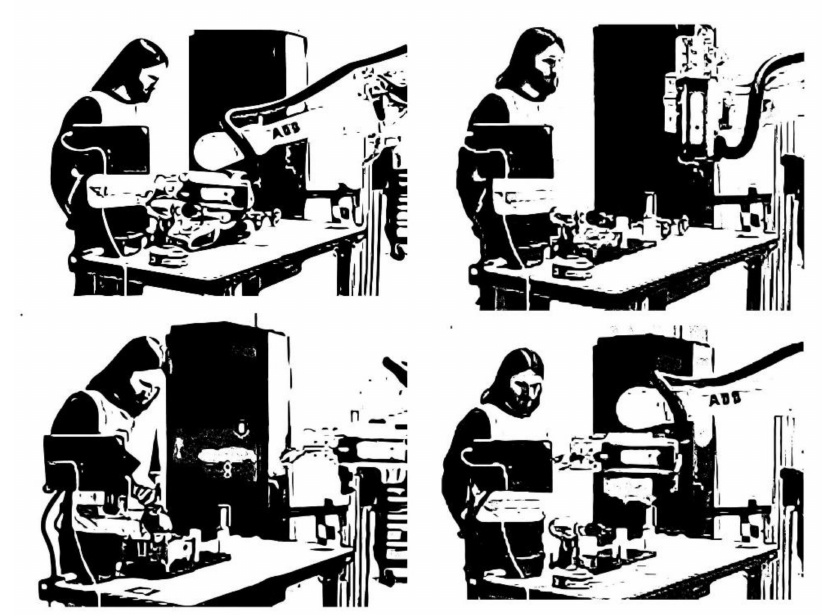
Figure 6. Illustrations of human-robot collaboration of assembly in